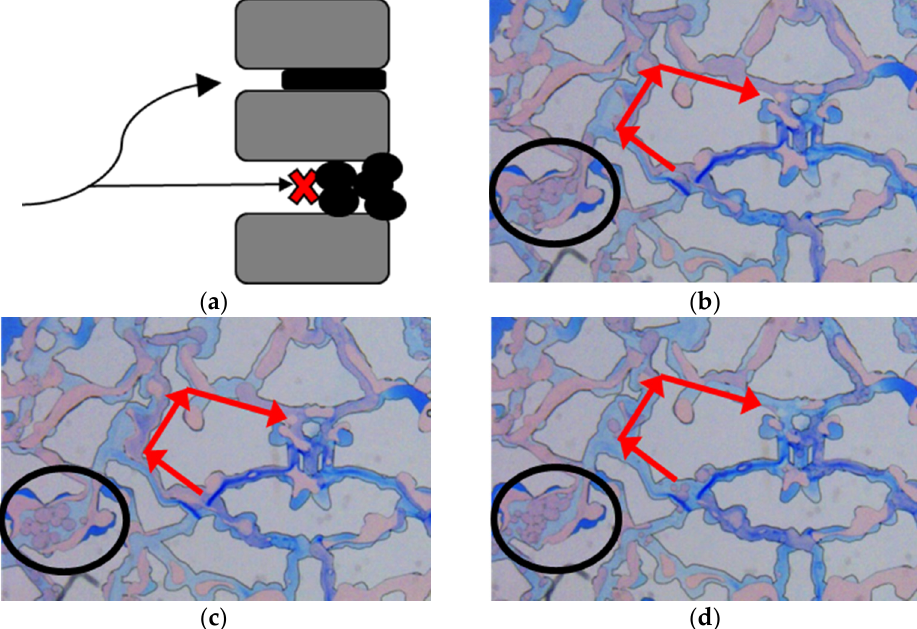
Figure 7. Heterogeneous model emulsifier injection and subsequent water invasion images: ( a ) sat- urated oil; ( b ) end of the first water flooding; ( c ) the emulsifier injected along the simulated “hori- zontal wellbore”; ( d ) end of the second water flooding.